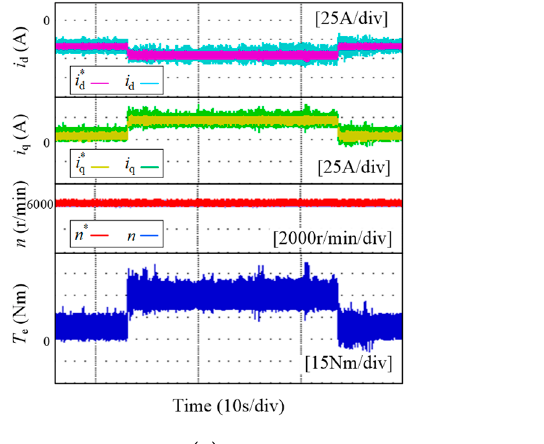
Table 2. The comparison of SD without parameter mismatches.